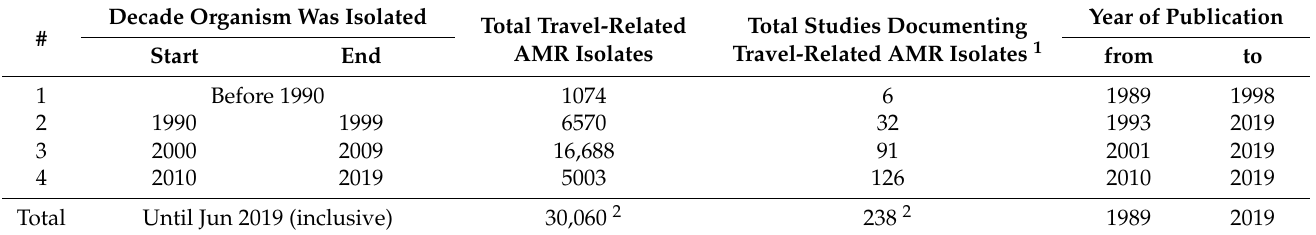
Table 1. Number of travel-related antimicrobial resistance isolates, documenting studies and year of publication categorised by decade of isolation: isolates that have isolation time frames that overlap decades were categorised into the earliest decade of this time